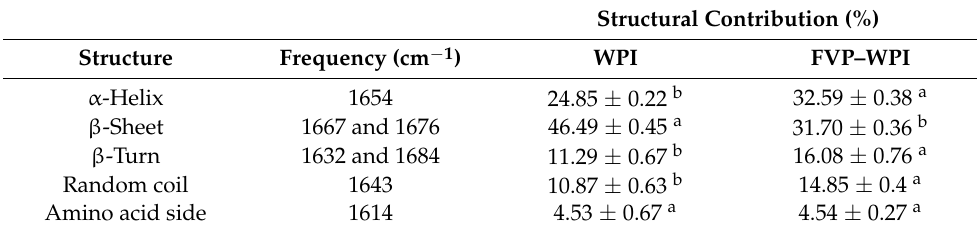
Table 2. Content of secondary structural components of WPI and